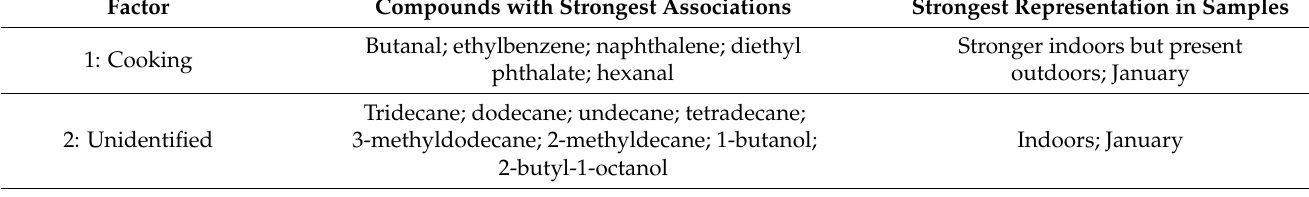
Table 2. Factors (sources) identified through non-negative matrix factorization and compounds with the strongest associations for each